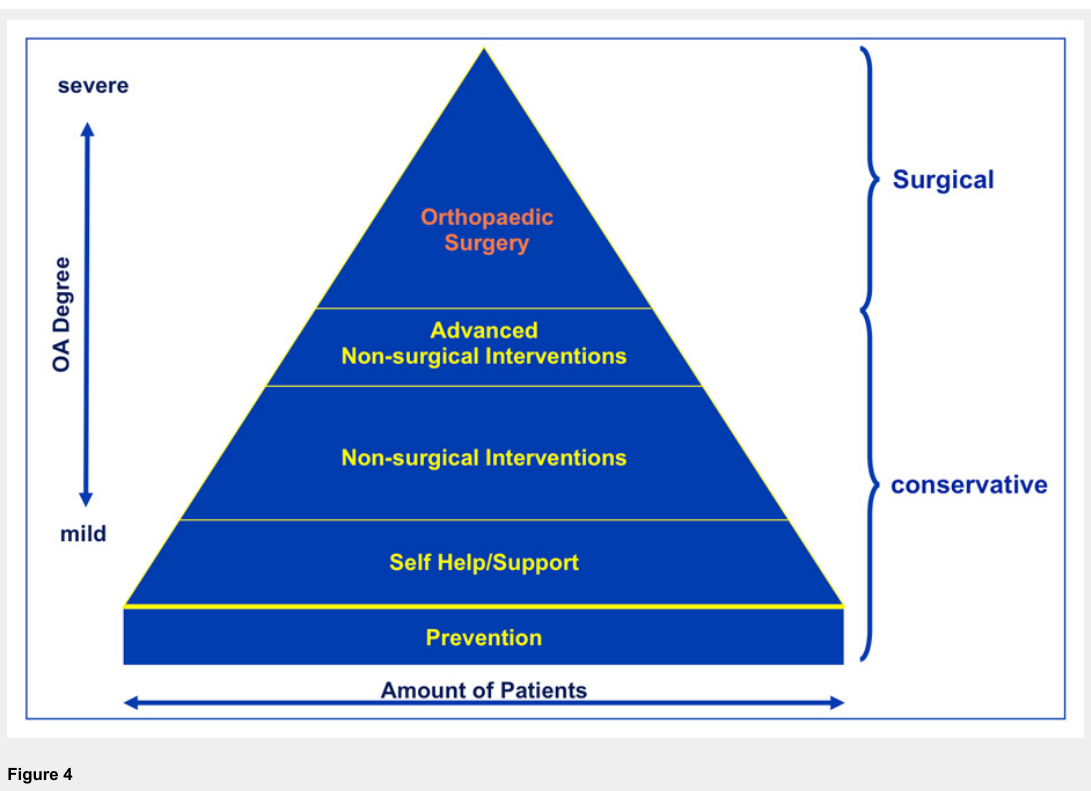
Figure 4 Treatment algorhythm for OA patients.